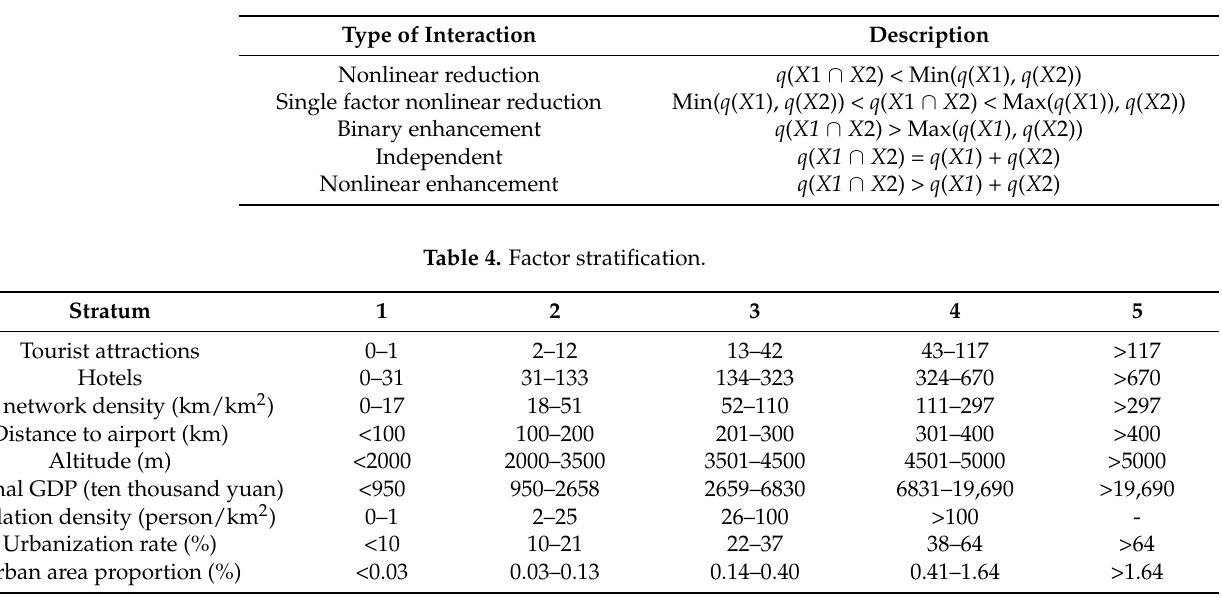
Table 3. Interaction between explanatory variables.